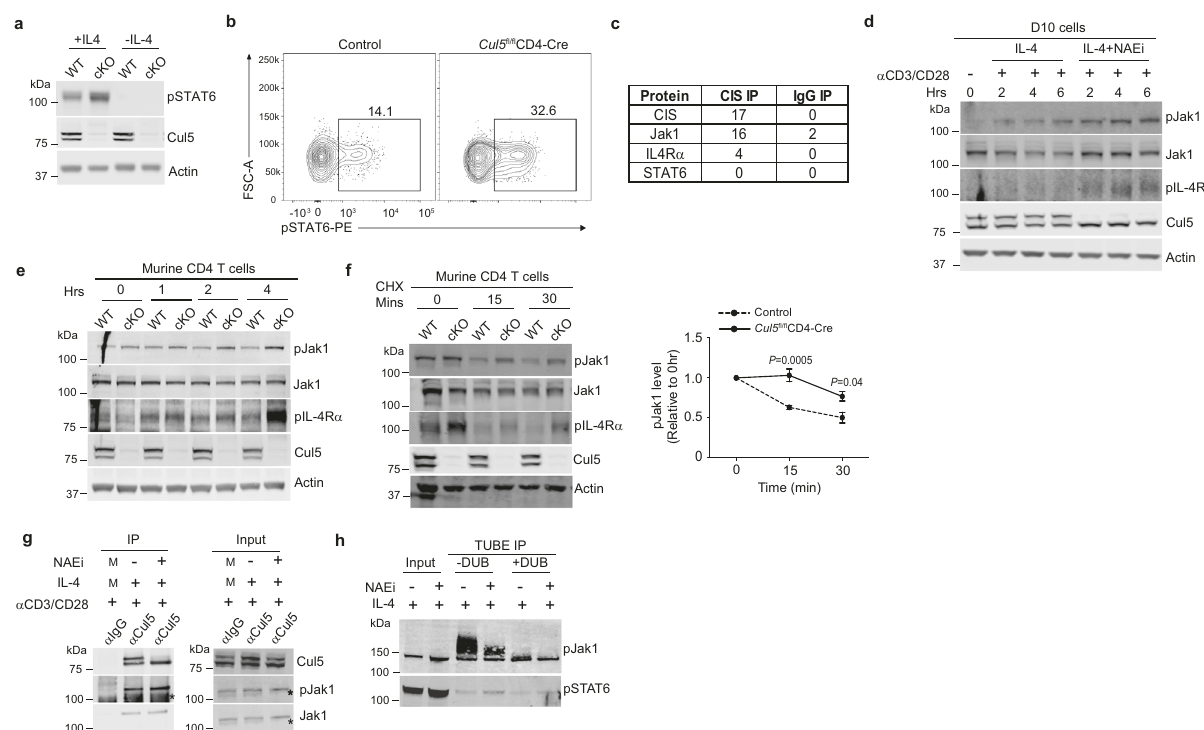
Fig. 6 CRL5 ubiquitinates and degrades pJak1. CD4 + T cells isolatedfrom 8 – 10 week old mice were stimulated for 24hrs washedand treatedwith 0.25ng/ml IL-4for 5min inplain RPMI media. a Immunoblot showing pSTAT6 levels in control and Cul5 fl / fl CD4-Cre CD4 + T cells. n = 3 biologicreplicates of cells examined in two independent experiments. b Flow plots showing pSTAT6 level in control and Cul5 fl / fl CD4-Cre CD4 + T cells by fl ow cytometry. n = 4 biologic replicates of cells examined in two independent experiments. c Table showing components of the IL-4 signaling pathway co-precipitated with CIS IP or IgG IP in D10 cells. n = 2 biologic replicates of cells examined in two independent experiments. d Immunoblot in D10 cells treated with IL-4 or IL-4 + NAEi for the indicated time. n = 3 biologic replicates of cells examined in three independent experiments. e Immunoblot of control and Cul5 de fi cient CD4 + T cells isolated from 8 – 10-week- old mice. Cells were treated with IL-4 for the indicated time. n = 3 biologic replicates of cells examined in three independent experiments. f Immunoblot of WT and Cul5 de fi cient CD4 + T cells stimulated with anti-CD3 and anti-CD28 for 48h in the presence of anti-IL-4. Cells were then washed, stimulated with IL-4 for 2h and washedagain,and treatedwithanti-IL-4along withCHXfortheindicatedtime.Graphontheright shows pJak1levels uponCHXtreatment relativeto0h. n = 3 biologic replicates of cells examined in three independent experiments. g Immunoblot of Cul5 IP in D10 cells. n = 3 biologic replicates of cells examined in three independent experiments M: Similar amounts of lysate from all conditions was pooled for that sample. h Representative immunoblot of TUBE immunoprecipitation. D10 cells were stimulated with anti-CD3 and anti-CD28 for 4h in the presence of IL-4 or IL-4 and NAEi. Cells were lysed and subjected to TUBE IP. The enriched fraction was divided into two parts, one part was treated with DUB and other was left untreated. 3% lysate was used for input ( n = 2 biologic replicates of cells examinedin two independent experiments).Data ispresented asmean±SEM in panel f . p -value wascalculatedby unpairedtwo tailed t test. Source data are provided as a Source Data fi